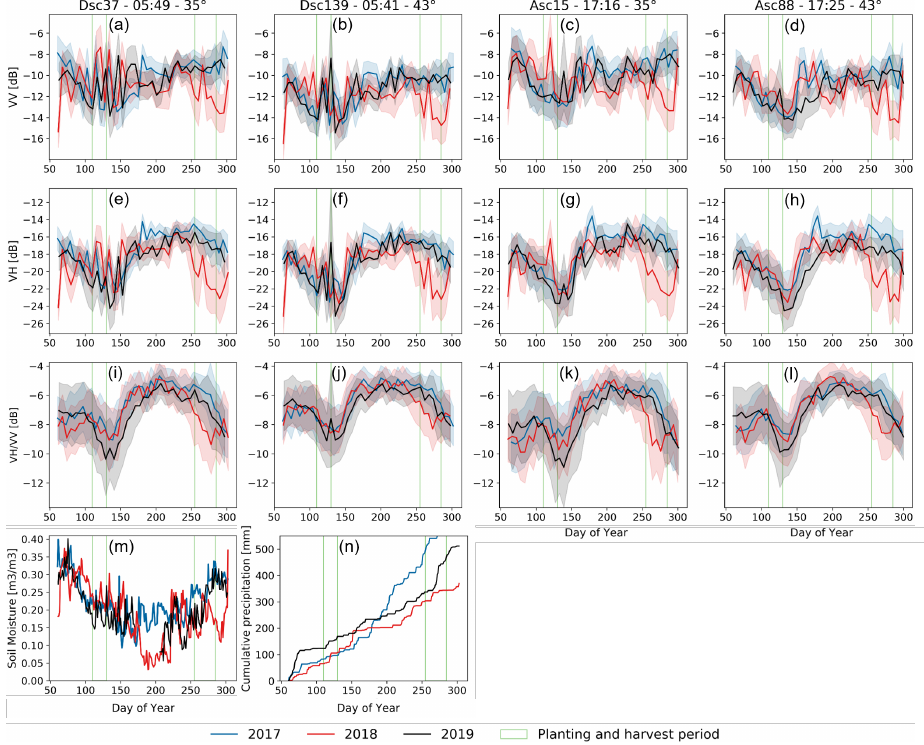
Figure 4. Sentinel-1 descending (RO: 37 and 139) and ascending (RO: 15 and 88) backscatter profiles of VV ( a–d ), VH ( e – h ) and VH/VV ( i – l ) for maize parcels in Vechtstromen-Noord for the years